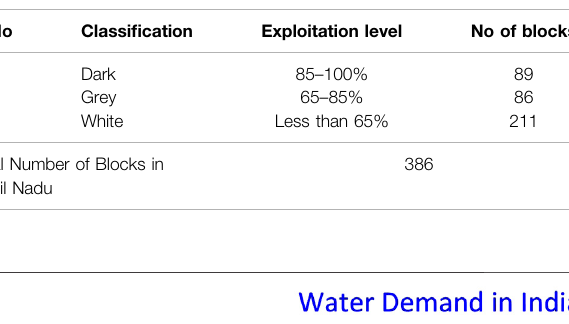
TABLE 1 | Groundwater exploitation level in Tamil Nadu. Source: CGWB